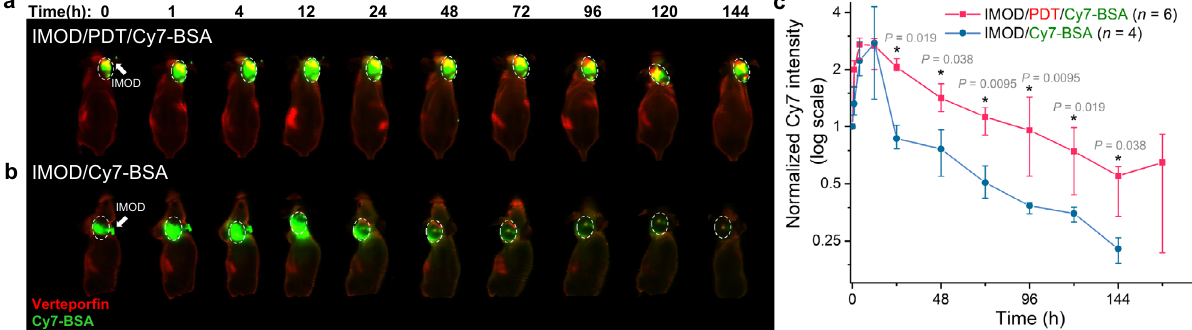
Fig. 3 Effect of photodynamic therapy (PDT) on intratumoral retention of proteins. Representative whole-body fl uorescence images of a 4T1 tumor – bearing nude mice with an implanted IMOD (white arrow) that received PDT (red, − 4 h) and Cy7 – bovine serum albumin (BSA) via IMOD (0 h). b 4T1 tumor – bearing nude mice that received Cy7-BSA via IMOD (0 h). In both panels, the tumors are indicated with white dashed circles. c Time course of normalized intratumoral Cy7 intensity over 1 week ( n = 4 – 6) for the mice shown in ( a ) and ( b ). Data are medians ± quartiles. Asterisks indicate P < 0.05, determined using Mann – Whitney U